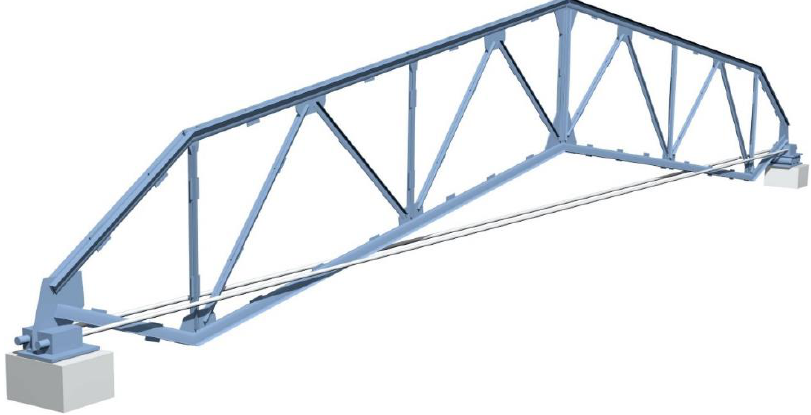
Figure 2. A new type of prestressed arched truss with a tie member offered by the